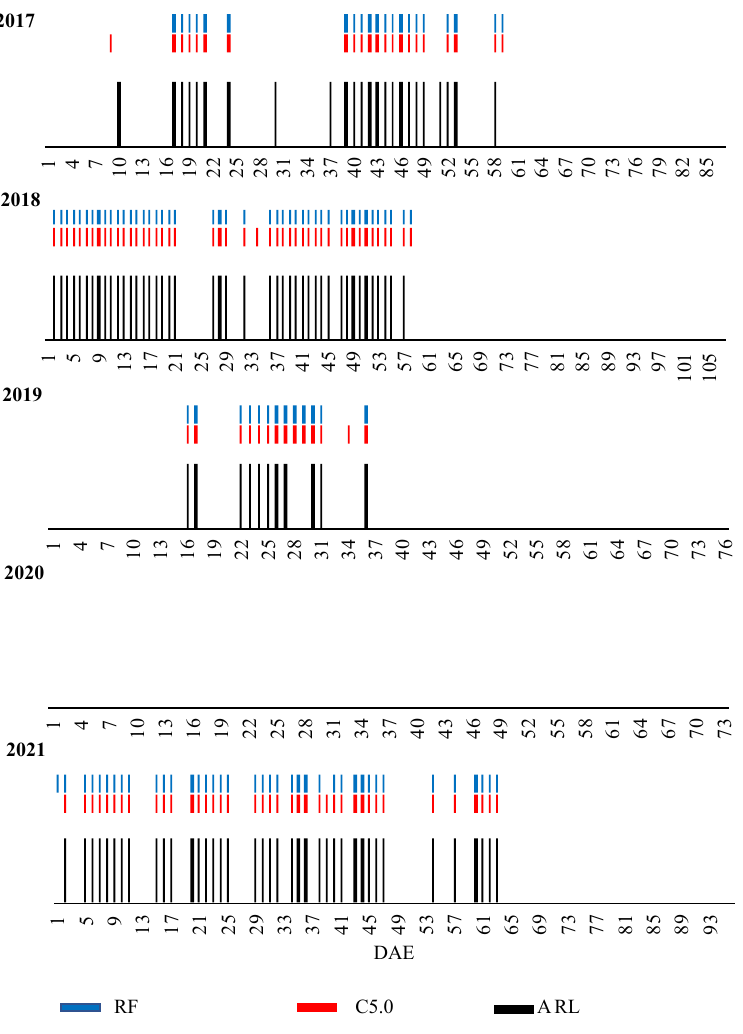
Figure 3. Comparison between prediction data by ML algorithms C5.0 and random forest (RF) and observed aerobiological risk level (ARL) by growing season. DAE: days after